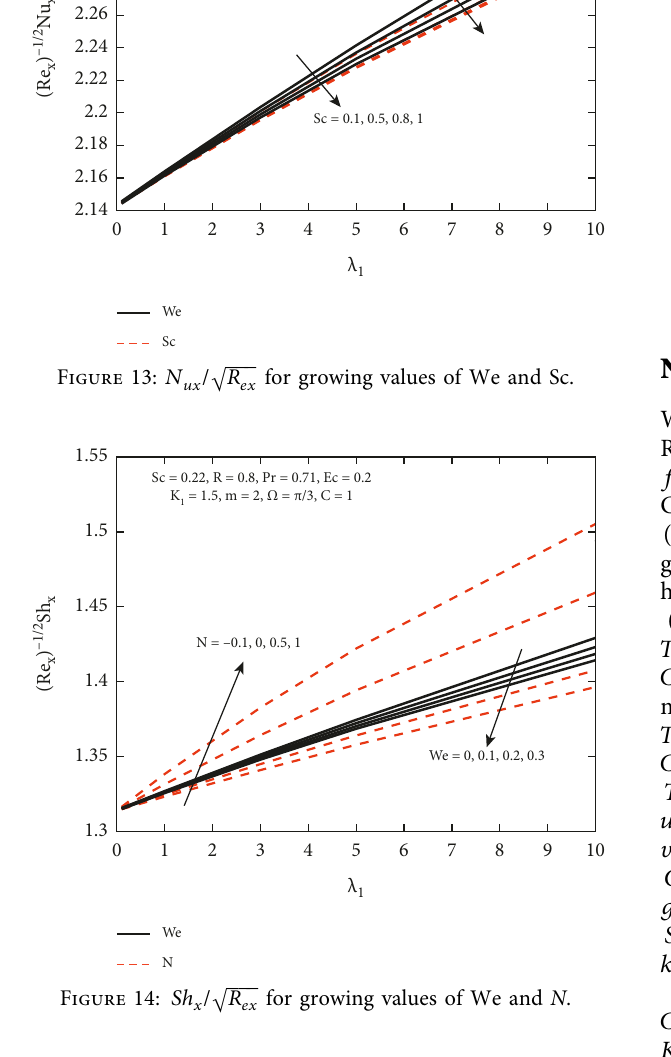
R for growing values of We and N x / ex (cid:26) (cid:27)(cid:27)(cid:27)